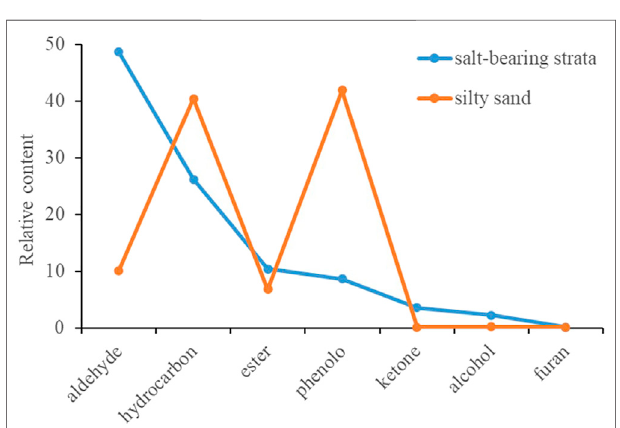
FIGURE 6 | Differences in the distribution of organic matter in different lithologic strata.